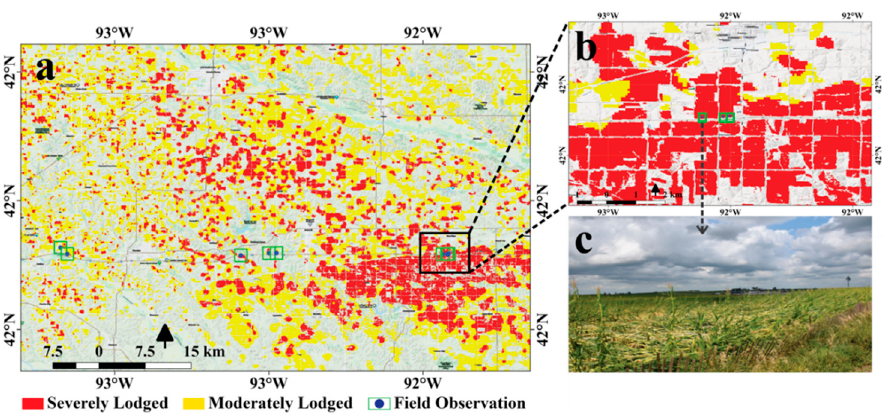
Figure 10. Location of field observations for ( a ) all the eight points and ( b ) a zoomed location for three points. ( c ) Photo for one of the field observations in “b”.